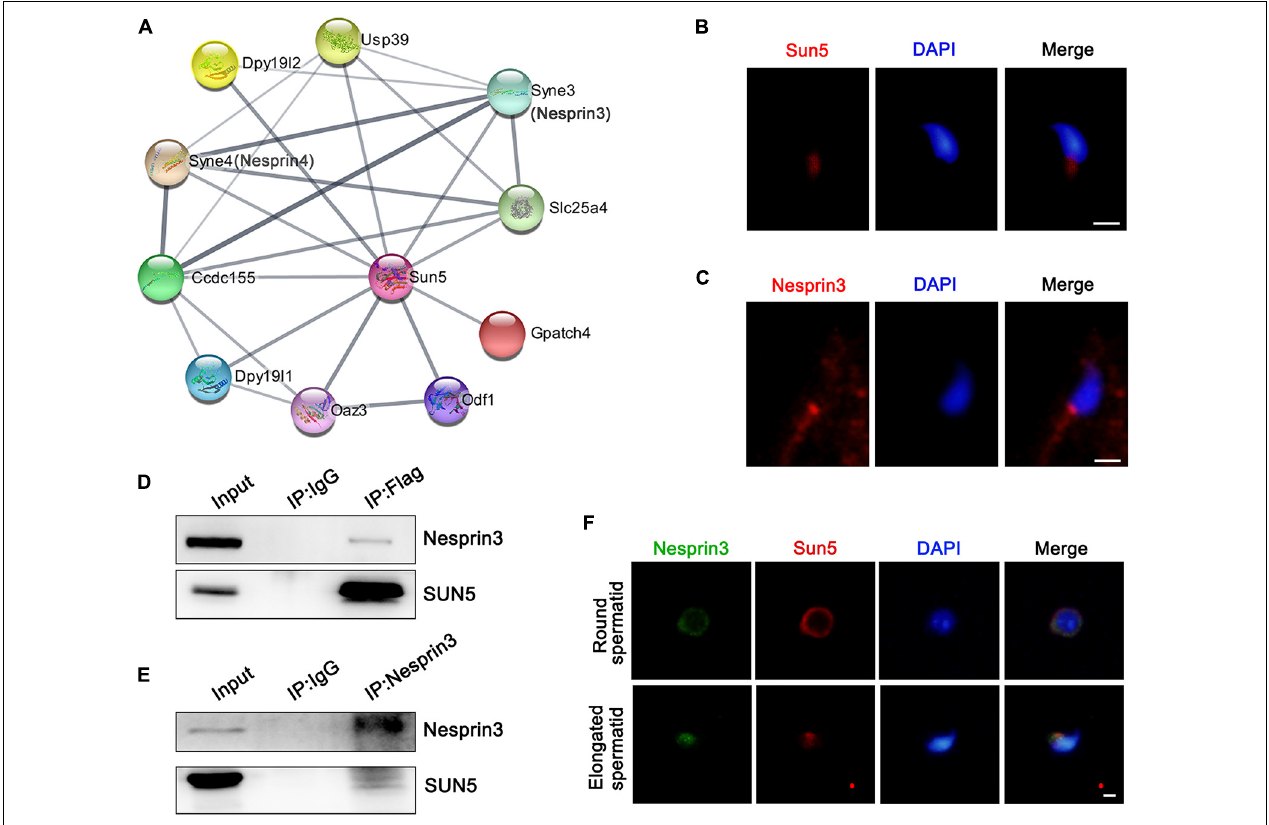
FIGURE 5 | Interaction between SUN5 and Nesprin3 forms the LINC complex. (A) Interaction network analysis of SUN5 in mice by the STRING database. (B) The localization of SUN5 in spermatozoa by immunofluorescence analysis in mice. Bars: 2.5 µ m. (C) The localization of Nesprin3 in spermatozoa by immunofluorescence analysis in mice. Bars: 2.5 µ m. (D,E) The physical interaction between SUN5 and Nesprin3 in vitro validated by co-IP analysis. (F) Colocalization of Sun5 with Nesprin3 in different stages of mouse spermatid development by immunofluorescence analysis. Bars: 5 µ m.